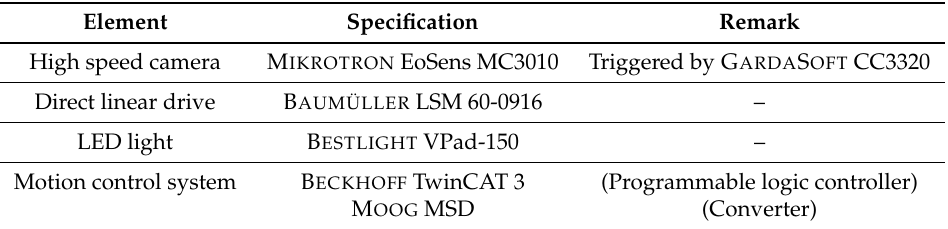
Figure 2. Experimental setup to investigate the linear transport unit’s motion’s influence on the liquid slosh behavior for different container geometries. The different containers are clamped into a mechanical socket that is coupled to a linear direct drive. Additionally, a high speed camera and LED lighting are fixed to the mechanical setup to observe the fluid’s surface. Table 1. Specifications of used hardware elements in the test